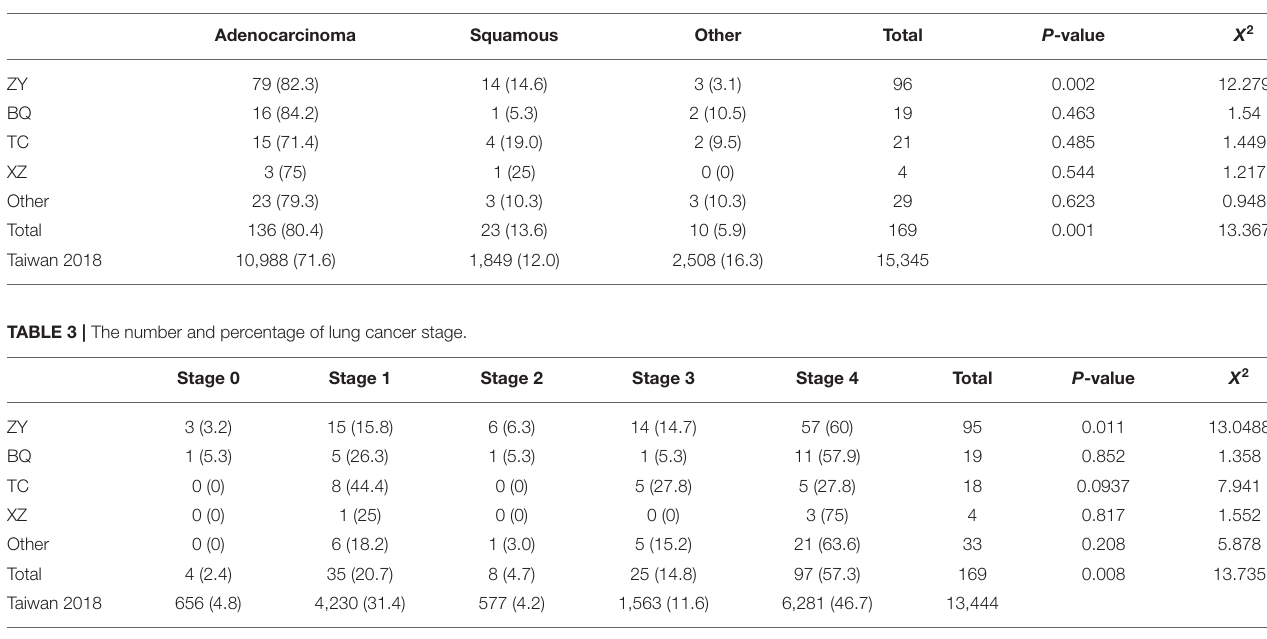
TABLE 2 | The number and percentage of lung cancer subtype.